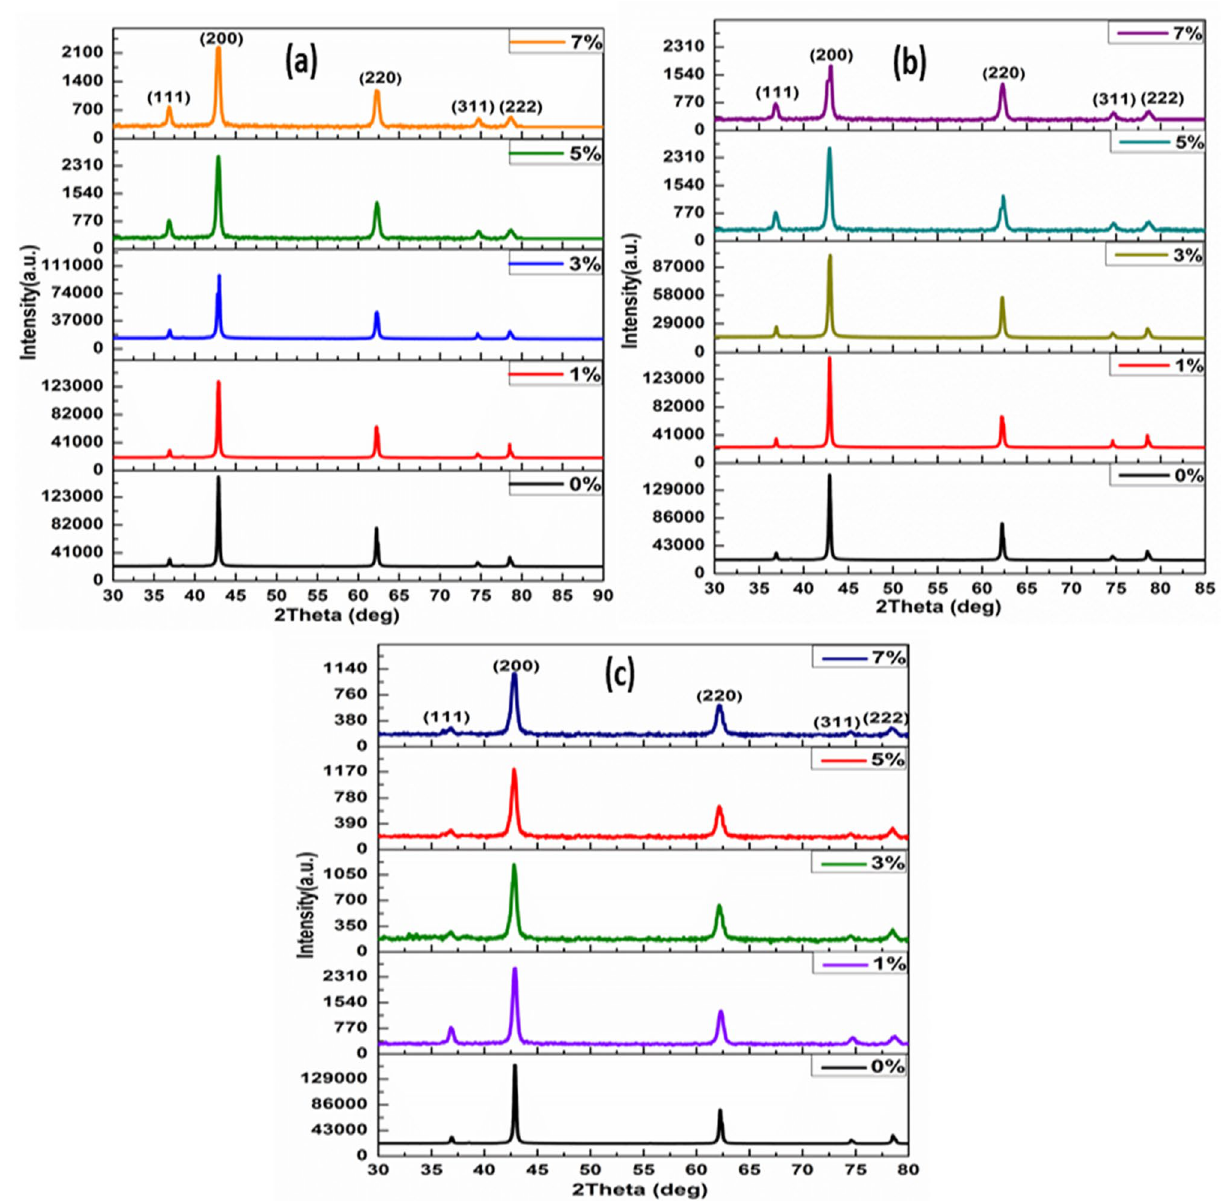
Figure 2. XRD of MgO pure and MgO doped with ( a ) Ni, ( b ) Co and ( c ) Fe for different concentrations (0%, 1%, 3%, 5%, and 7%)